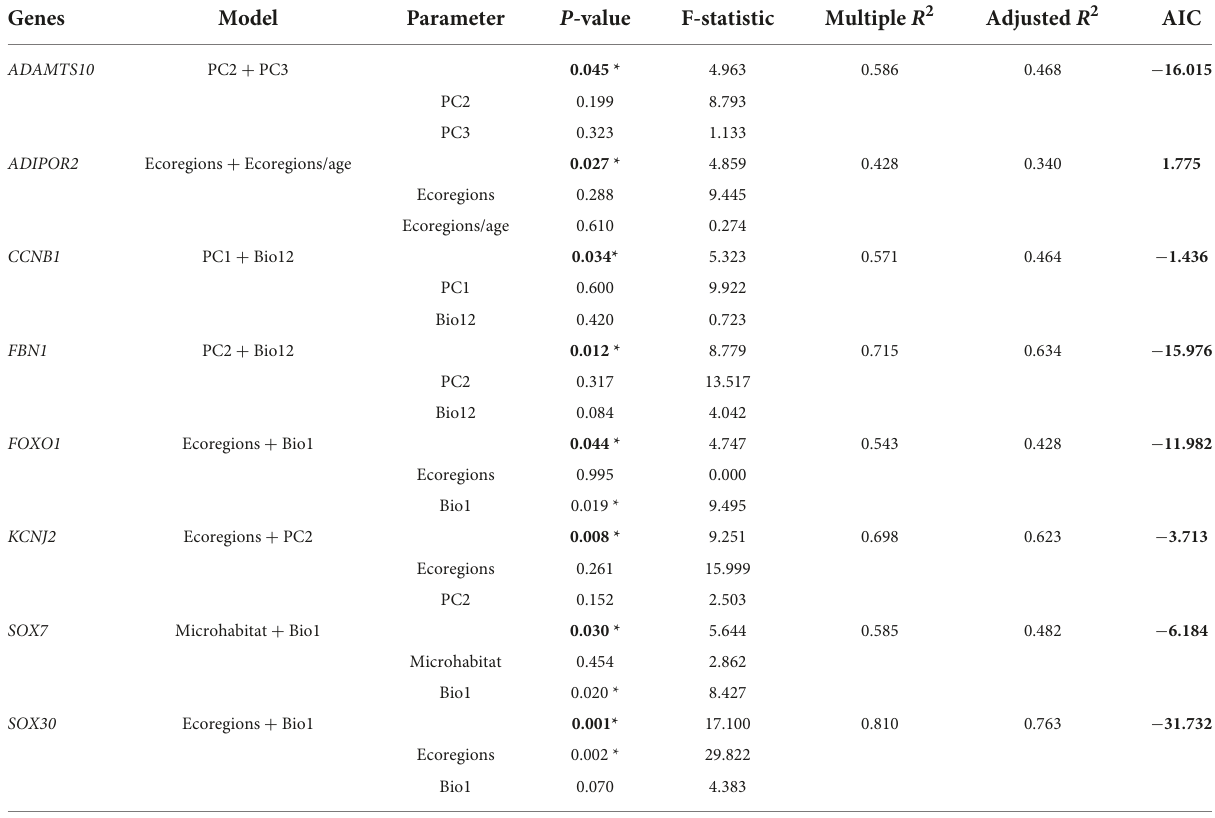
TABLE 6 Multiple regression analyses of the relationships between gene evolution and ecological factors in snakes.